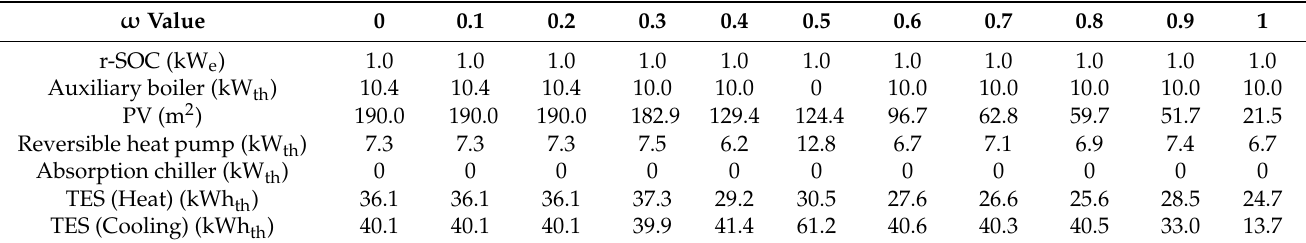
Table 2. Optimized configurations of the MES on the Pareto